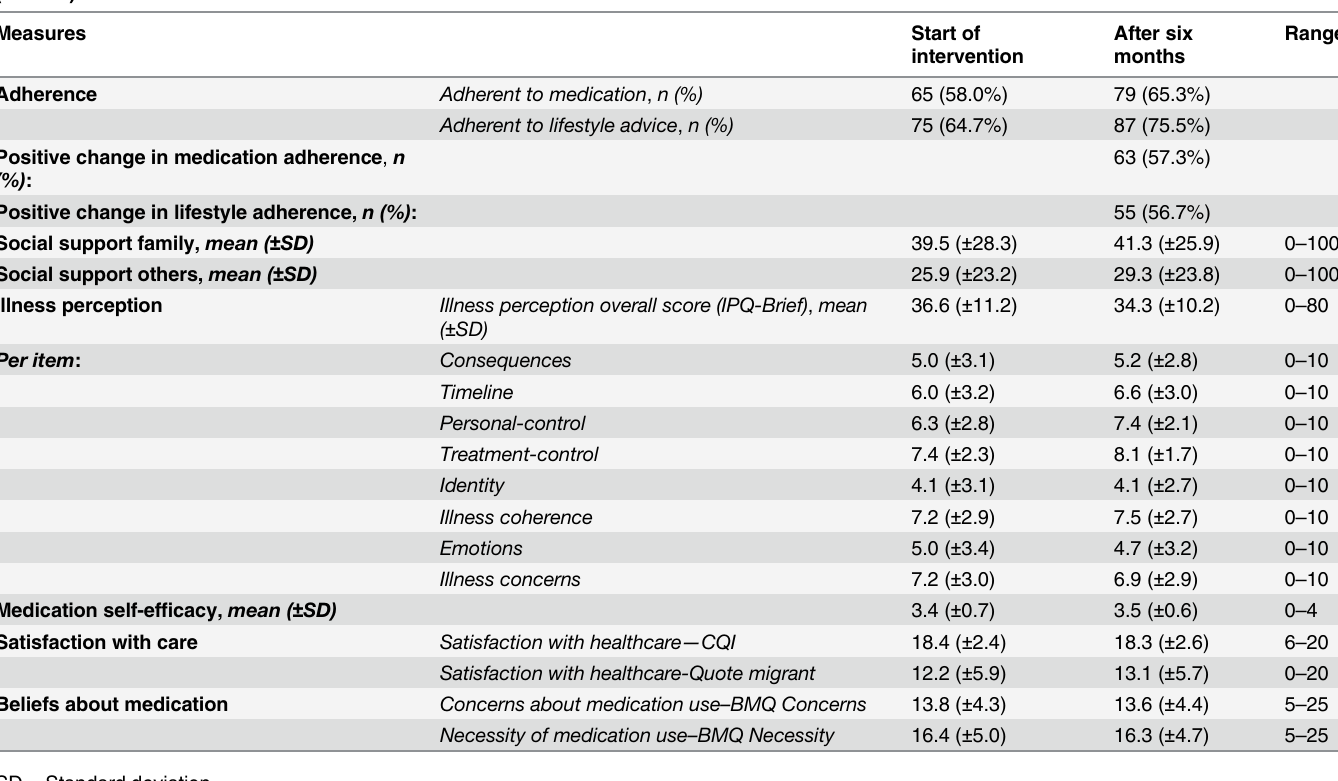
Table 1. Patient scores on measures for treatment adherence and patient-related determinants of adherence taken at baseline and six months (N = 139). Measures Start of